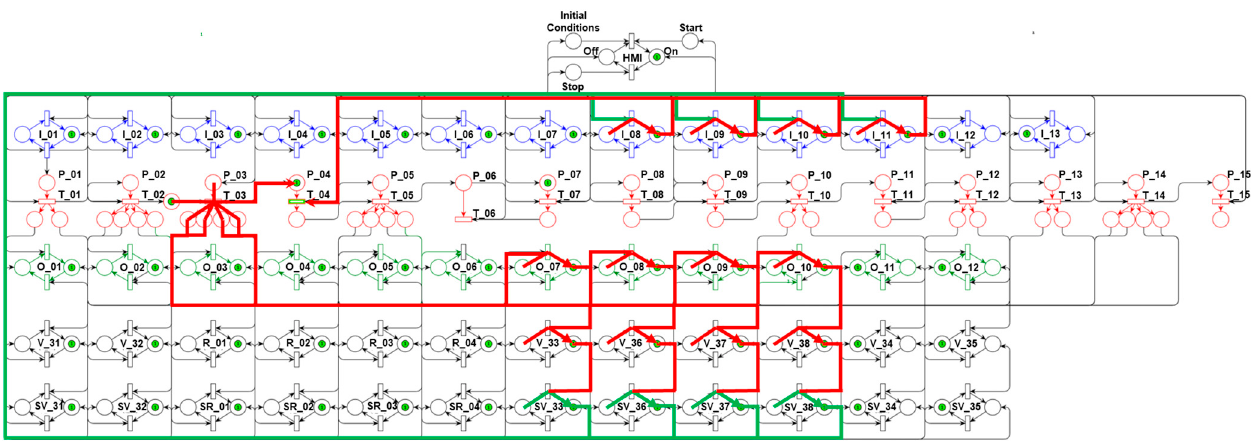
Figure 14. Algorithm’s fourth step—Open valves.